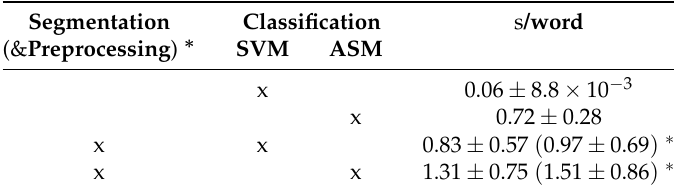
Table 6. Computational Time per